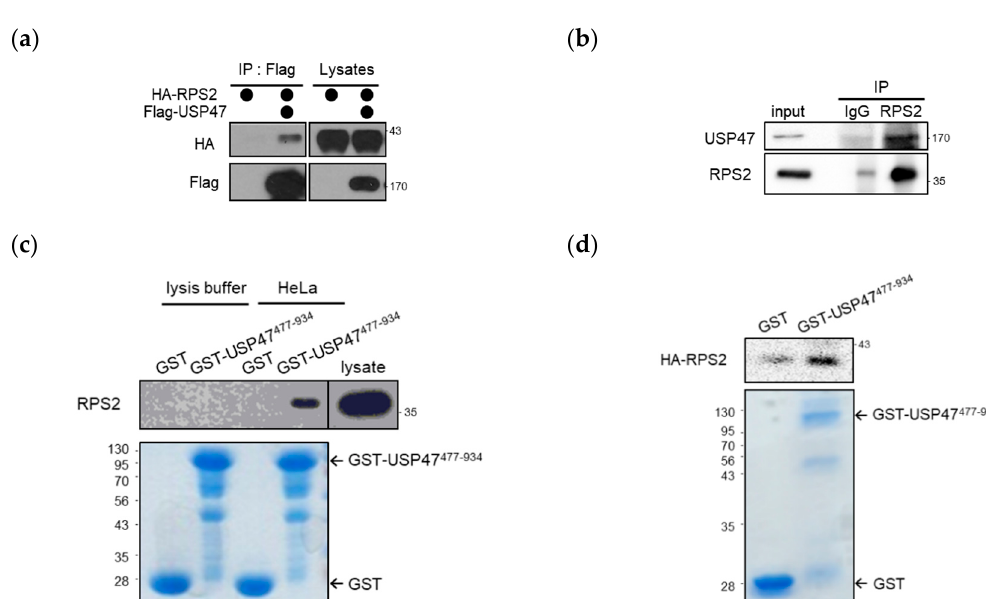
Figure 1. Ubiquitin Specific Protease 47 (USP47) interacts with ribosomal protein S2 (RPS2). ( a ) HEK293T cells were co-transfected with Flag-USP47 and HA-RPS2, and the cell lysates were immunoprecipitated with anti-Flag M2 agarose and detected with the indicated antibodies. ( b ) HEK293T cell lysates were immunoprecipitated with control IgG or anti-RPS2 antibodies, then the immunoprecipitates were detected with the indicated antibodies. ( c ) GST or GST-USP47 477–934 was immobilized on glutathione beads and incubated with HeLa cell lysates. Bound proteins were separated in SDS-PAGE and immunoblotted with anti-RPS2 antibodies. ( d ) GST or GST-USP47 477–934 was immobilized on glutathione beads and incubated with in vitro transcribed and translated HA-RPS2. Bound proteins were separated by SDS-PAGE and detected by Western blotting and Coomassie staining. The uncropped blots and molecular weight markers are shown in Figure S7.